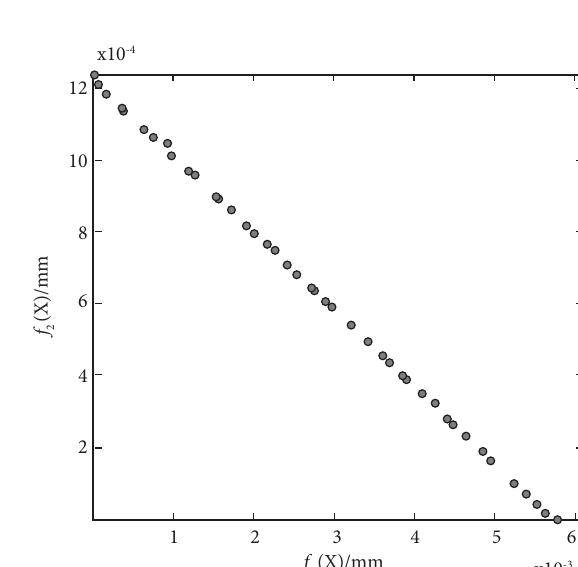
Figure 6: Optimal solutions for the diameter f